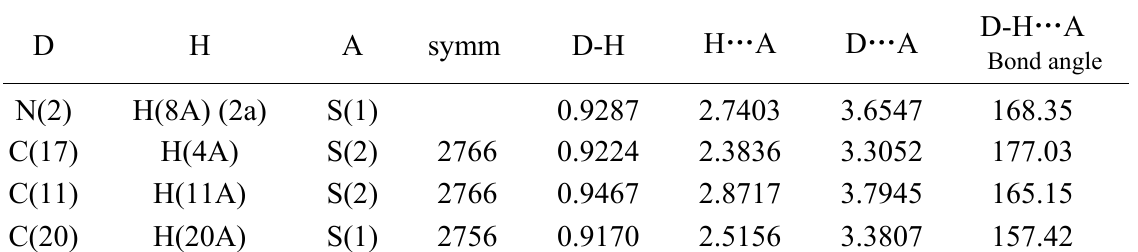
Table 3 Hydrogen bond distances (¯) and angles of title